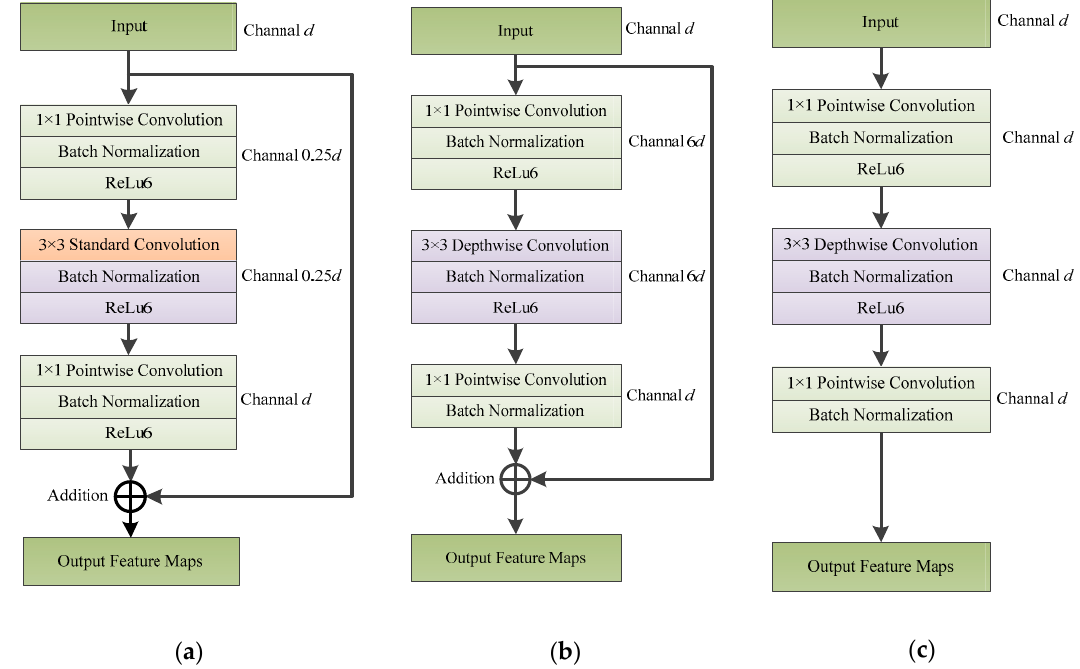
Figure 6. Blocks in a convolutional neural network (CNN): ( a ) standard residual block; ( b ) inverted residual block in MobileNetv2 when stride is 1; ( c ) linear block in MobileNetv2 when stride is 2.